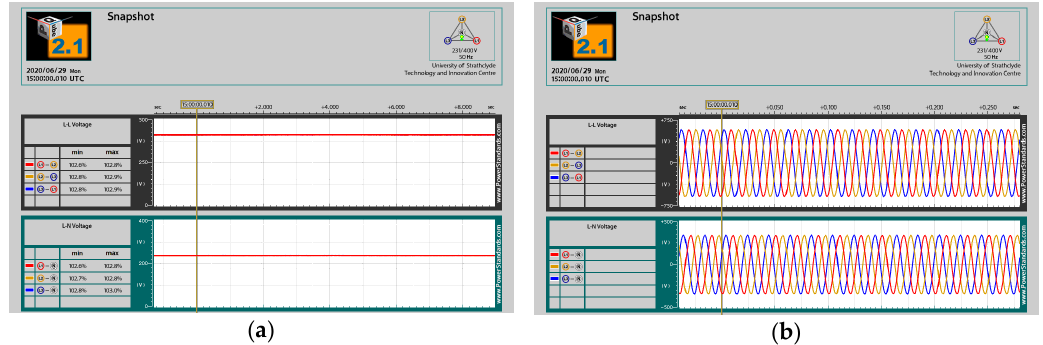
Figure 22. An actual voltage snapshot recorded by PQube at the University of Strathclyde on 29 June 2020 [45]: ( a ) the RMS voltage profiles; ( b ) the voltage waveforms.